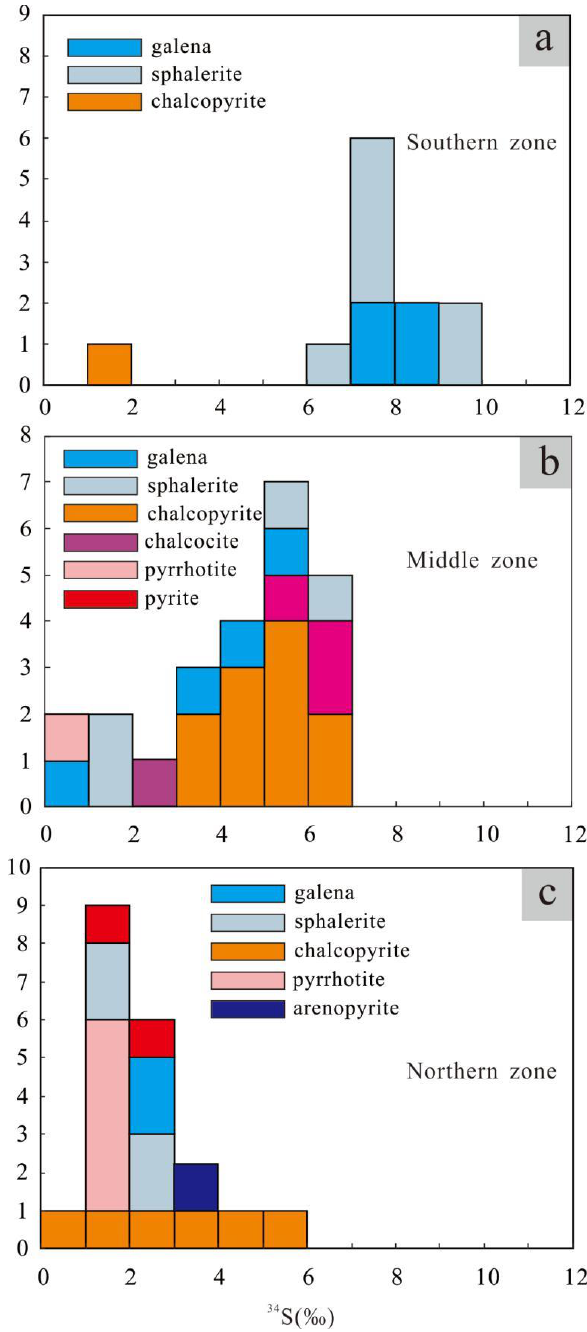
Figure 11. Histogram of sulfur isotopes of the Hutouya deposit. ( a ) 34 S isotopic compositions of ore minerals for the southern zone within the Hutouya deposit; ( b ) 34 S isotopic compositions of ore minerals for the middle zone within the Hutouya deposit; ( c ) 34 S compositions of ore minerals for the northern zone within the Hutouya deposit.